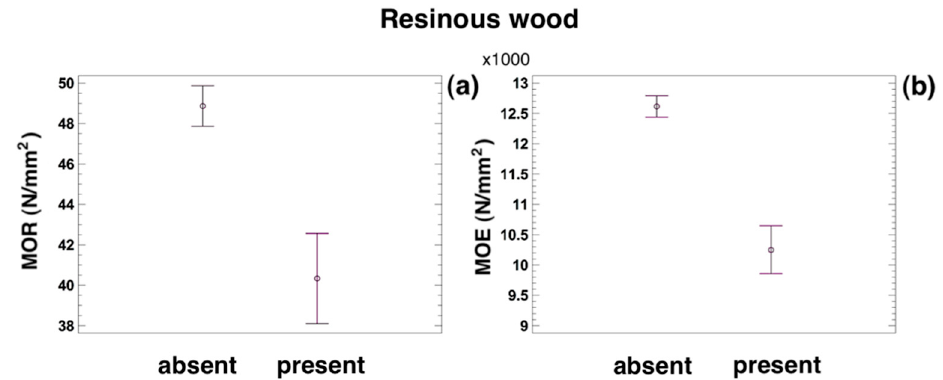
Figure 6. Least significant difference (LSD) diagrams of the influence of presence/absence of resinous wood on ( a ) MOR (Grade ME-2) and ( b ) MOE (Grade ME-2).